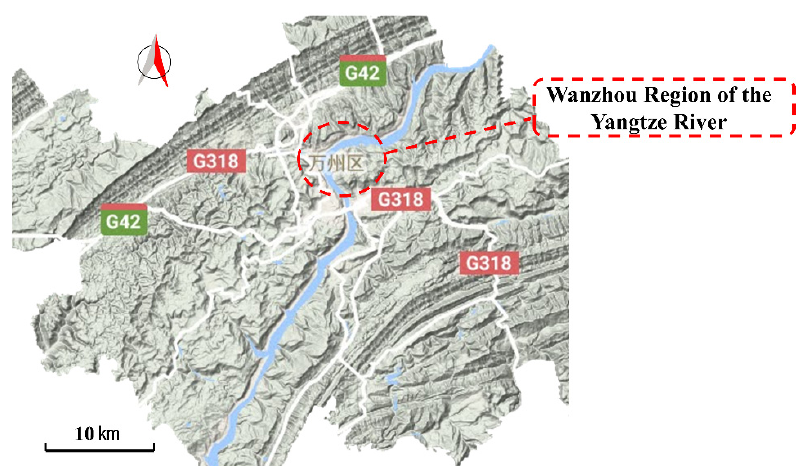
Figure 3. Schematic of Wanzhou region of the Yangtze River.